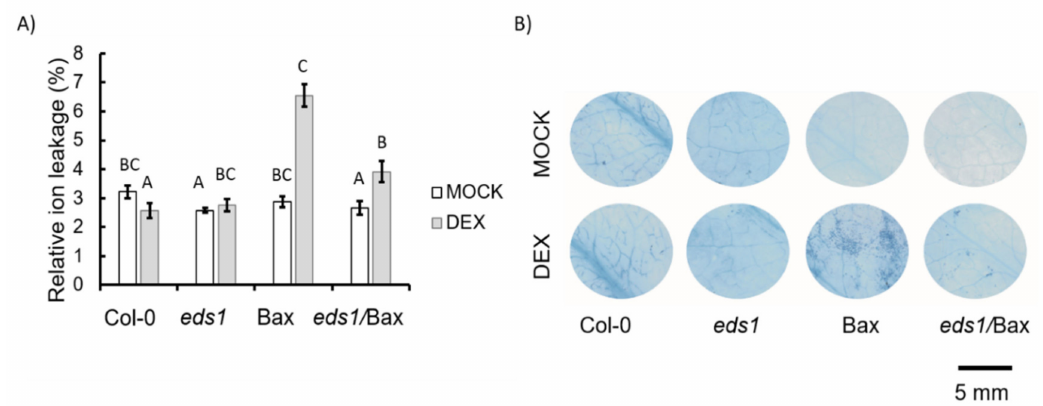
Figure 2. Cell death in the wild type, eds1 mutants, and Bax and eds1 / Bax lines ( + mock /+ DEX) shown as ( A ) ion leakage and ( B ) trypan blue staining of dead cells: within a subgraph, values sharing common labels (letters) are not significantly di ff erent from each other ( p > 0.001) ( n =